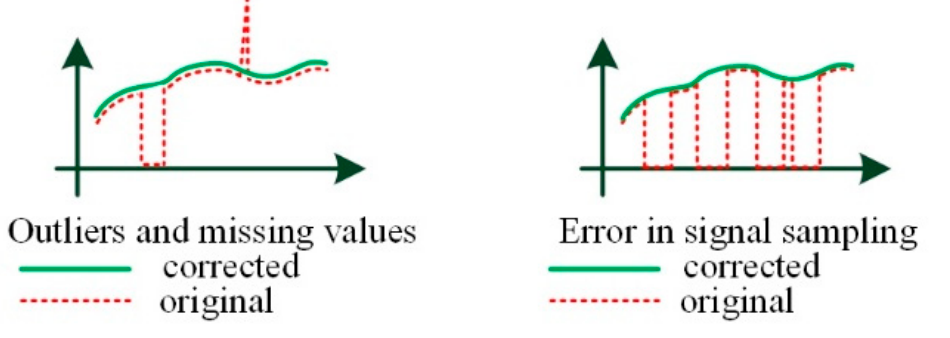
Figure 4. Examples of data quality problems, covered by the data preparation part of the quality assurance